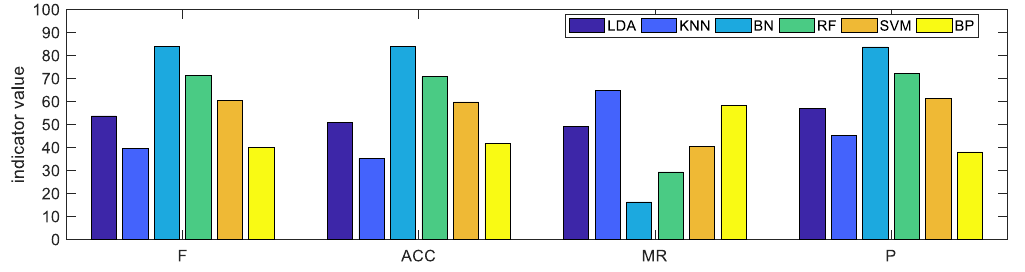
Figure 5. Value of each base classifier relative to each performance evaluation indicator.